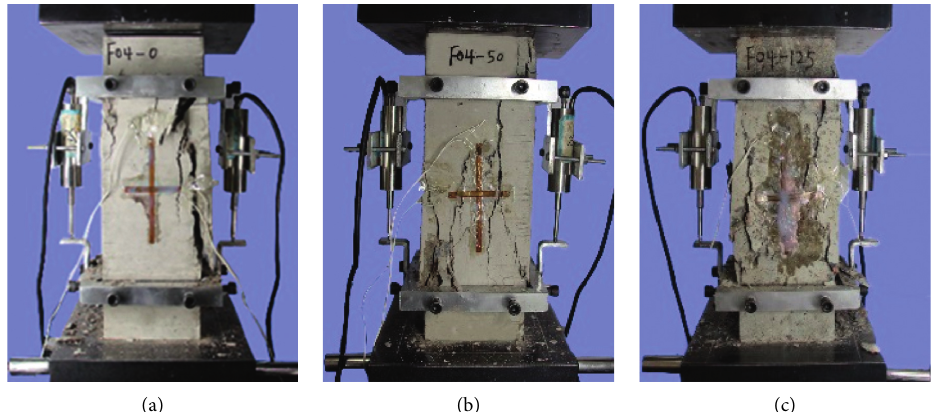
Figure 7: Typical failure pictures of OC specimen F01 under different freeze-thaw cycles. (a) 0 times. (b) 50 times. (c) 125 times.